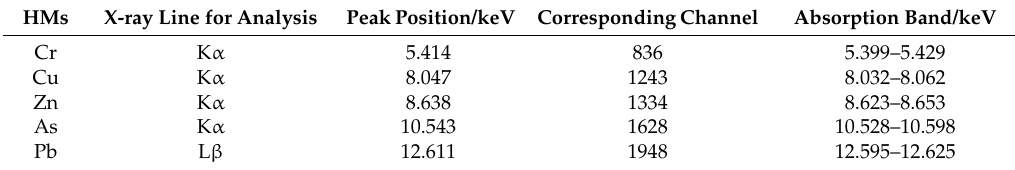
Table 1. Characteristic X-ray line, peak position and absorption band of five HMs.